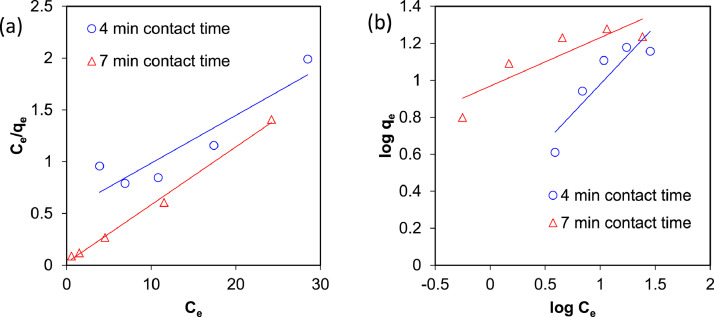
Adsorption isotherms for AO10 removal on TiO2/zeolite composite of a) Langmuir and b) Freundlich.